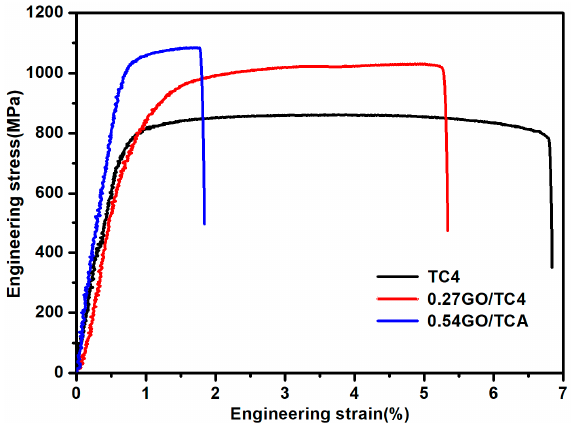
Figure 6. Tensile stress–strain curves of the sintered samples with different contents of GO nanosheets. Table 1. Mechanical properties of SPSed TC4 and GO/TC4 composites.